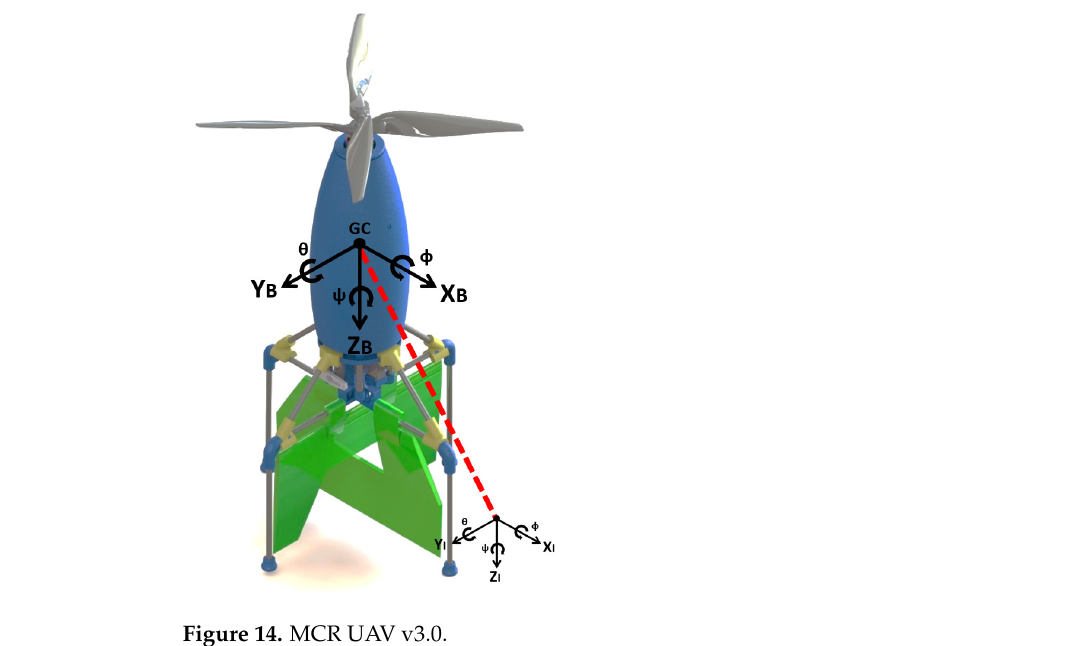
Figure 14. MCR UAV